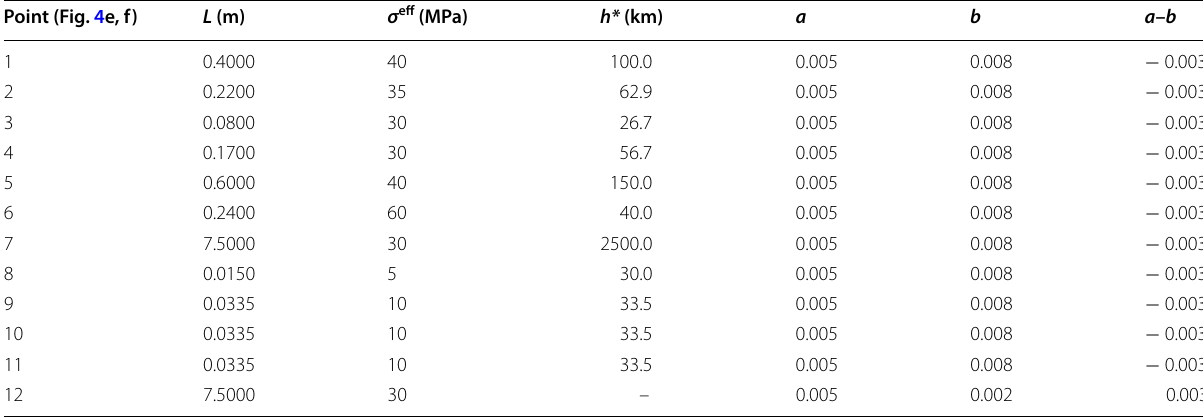
Table 2 Parameters in our best simulation model at points 1–12 in Fig. 4e, f Point (Fig. 4e,